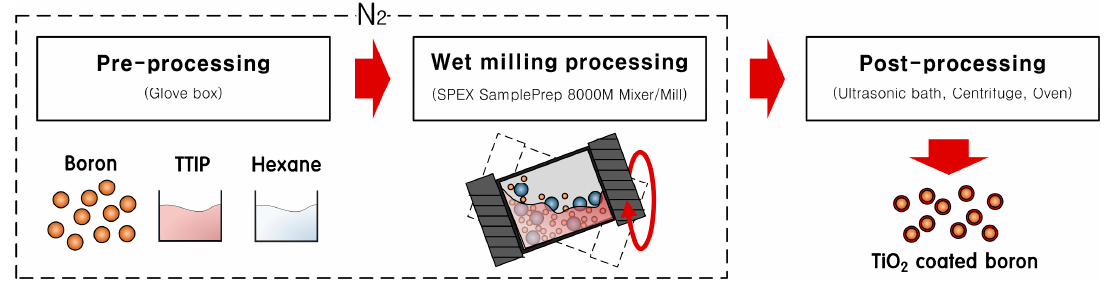
Figure 11. Schematic diagram of the wet ball milling process.